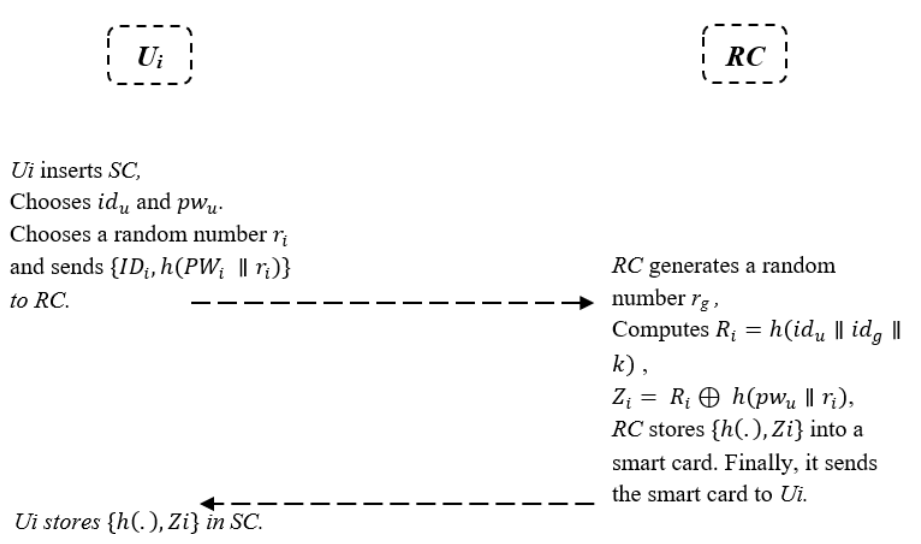
Figure 5. User registration